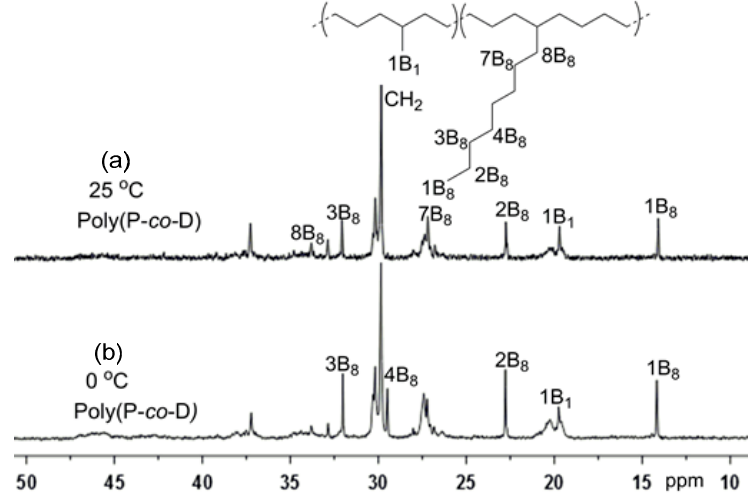
Figure 4. 13 C NMR spectra of poly(P -co- D)s obtained by 2 -MMAO at ( a ) 0 and ( b ) 25 °C (Table 3, entry 1 and 2).